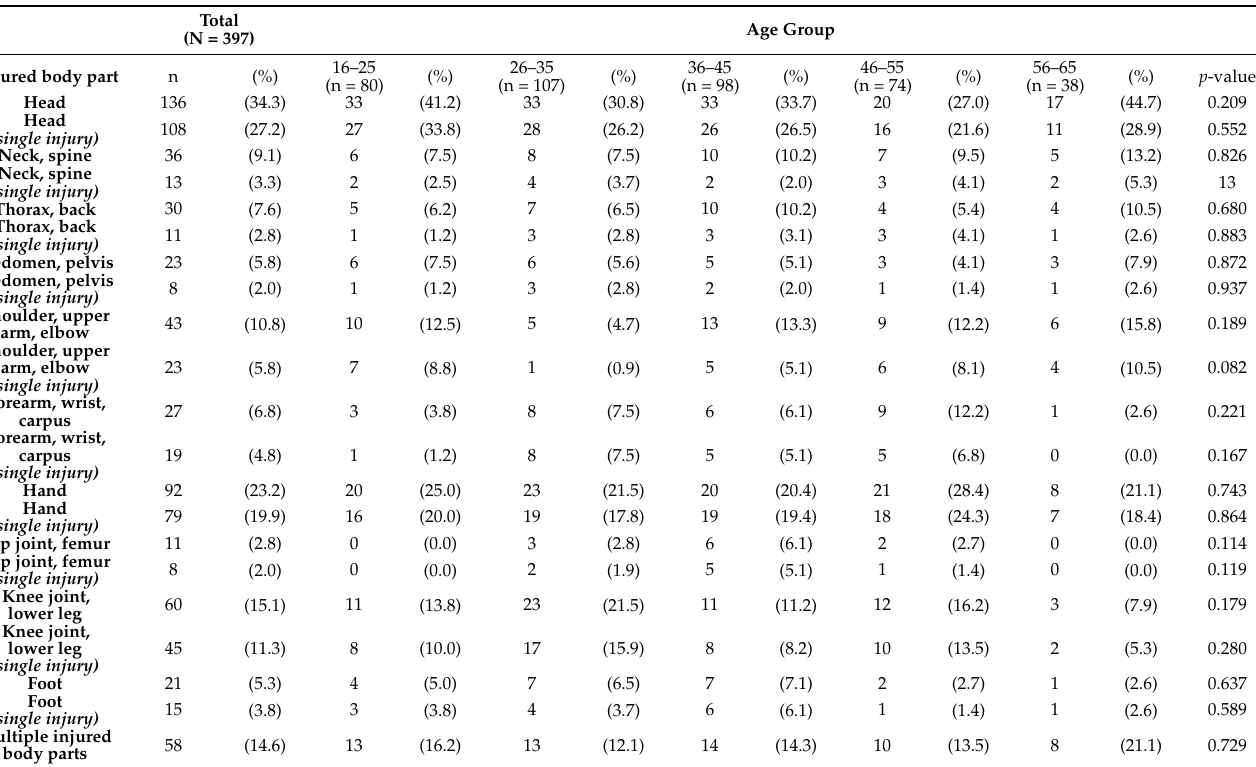
Table 1. Distribution of injured body part among construction workers in Switzerland according to age